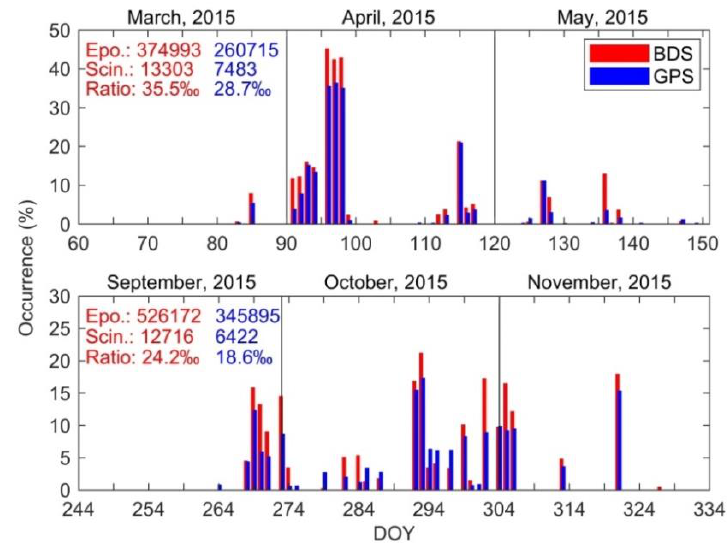
Figure 3. Daily occurrence rate of BDS and GPS scintillation observed at HKST station in spring (March–May) and autumn (September–November) of 2015. The statistics of available epochs, scintillation events, and the corresponding ratio values are given in the top left corner of each panel.